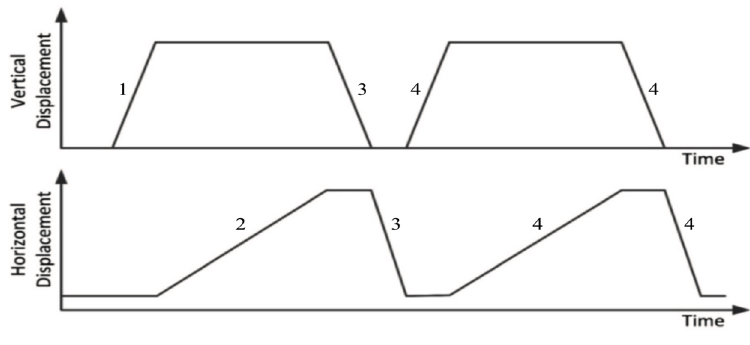
Figure 8. Schematic plot of the sliding protocol, showing normal and tangential motion of the stimuli: (1) move stimulus vertically into the sensor at 0.5 mm/s for 2 s (1 mm indentation); (2) slide stimulus across sensing area at 0.5 mm/s for 16 s (8 mm sliding); (3) retract at same speed and return to start location; (4) immediately repeat